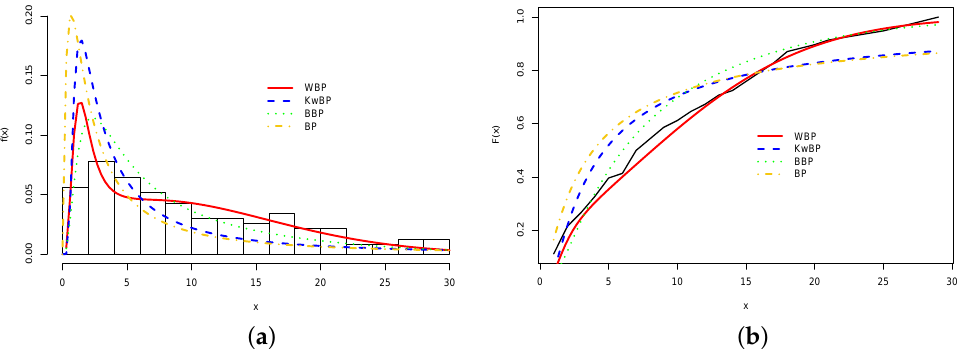
Figure 6. ( a ) Best estimated densities for COVID-19 data in Florianópolis; ( b ) empirical and corre- sponding estimated cumulative